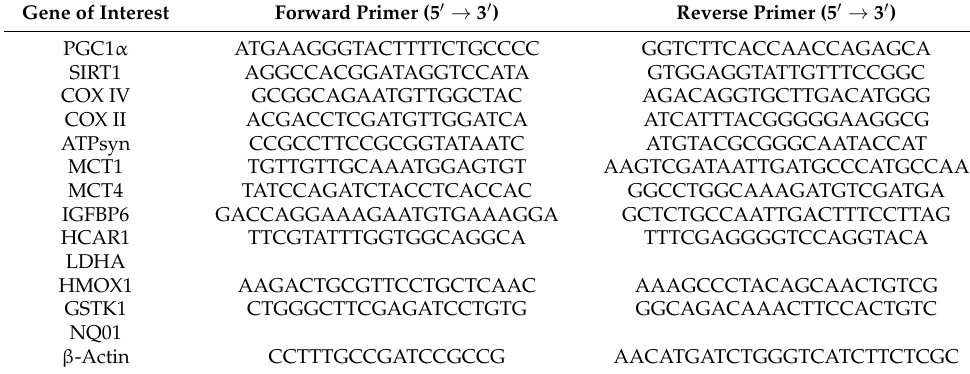
Table 1. Gene of